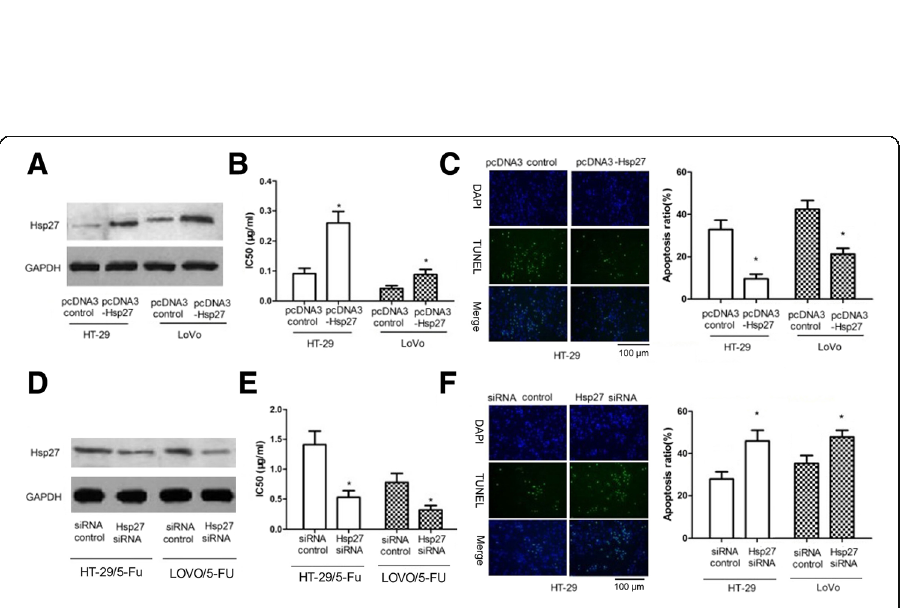
Fig. 4 Hsp27 affects the sensitivity of colon cancer cells to 5-FU. a , b and c – HT-29 and LoVo cells were transfected with pcDNA3-Hsp27 or pcDNA3 controls. Hsp27 protein expression was detected at 48 h post- transfection via western blot ( a ). After cells were incubated with 5-FU at concentrations of 0.0016, 0.008, 0.04, 0.2 and 1.5 μ g/ml for 48 h,IC 50 values were determined using CCK-8 assays ( b ). After the cells were incubated with 0.05 μ g/ml 5-FU for 48 h, cell apoptosiswas determined using TUNEL assays ( c , scale bar = 100 μ m). d , e and f – HT-29 and LoVo cells were transfected with Hsp27 siRNA or siRNA controls. Hsp27 protein expression ( d ), IC 50 ( e ) and cell apoptosis ( f , scale bar = 100 μ m) were assessed. Data represent the means ± SEM from three independentexperiments. * p <